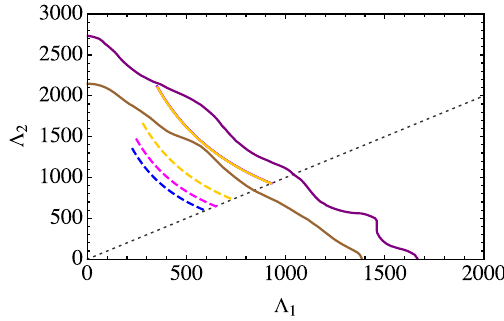
Fig. 5 ((cid:2) 1 ,(cid:2) 2 ) relation obtained for the case of GW170817. The purple-solid line stands for the 90% probability contours given in Fig. 5 of Ref. [3], and the brown-solid line represents the 90% probability contours given in Fig. 10 of Ref. [4]. The black-dotted line stands for (cid:2) = (cid:2) 2 1